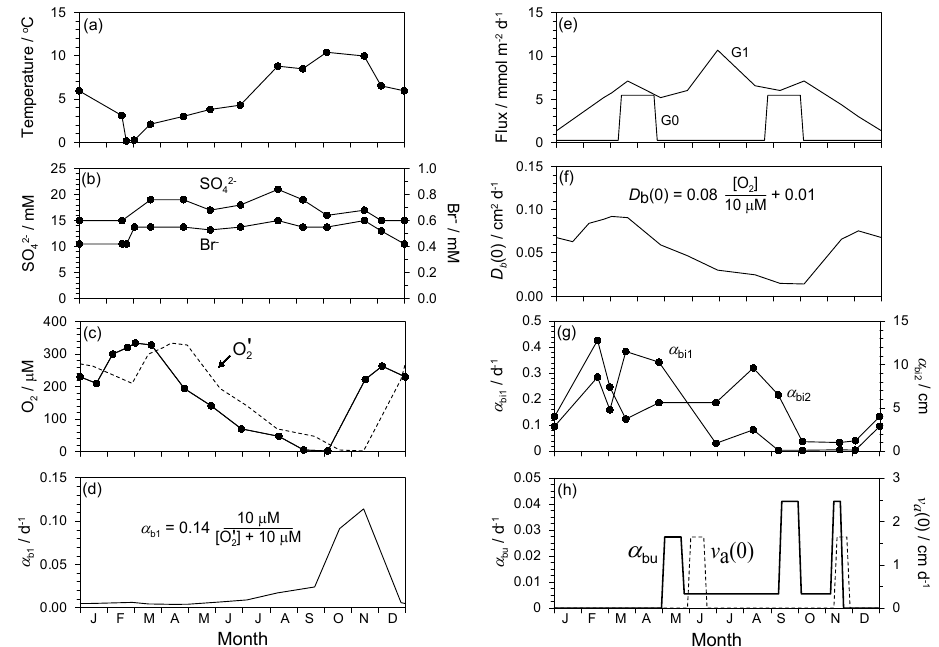
Fig. 2. Time-dependent boundary conditions and forcing functions used in the model. (a) Temperature, (b) bottom water sulfate and bromide, (c) bottom water dissolved oxygen and the time-lagged values (O 0 ) used in several rate expressions (P uptake and release by Beggiatoa , 2 Fe(OH) 3 reduction by sulfide and nitrate transport by sulfide oxidizing bacteria), (d) nitrate transport by sulfide oxidizing bacteria defined by the equation shown. Panel (e) shows the G0 and G1 organic matter fluxes, (f) is the bioturbation coefficient defined by the equation given in the panel, (g) shows the bioirrigation coefficients ( α bi1 and α bi2 ) determined from the ex situ experiments, and (h) is the bubble irrigation coefficient ( α bu ) and enhanced advection of dissolved methane ( v a (0)). The symbols in (a) , (b) , (c) and (g) denote values that have been measured except from those at the beginning and the end of the year which are interpolated. Linear interpolations were used between the data for modeling